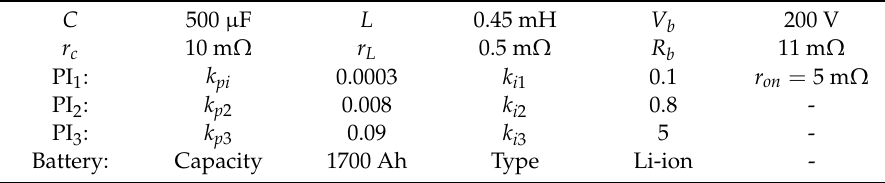
Table 3. Conventional BDC parameters.